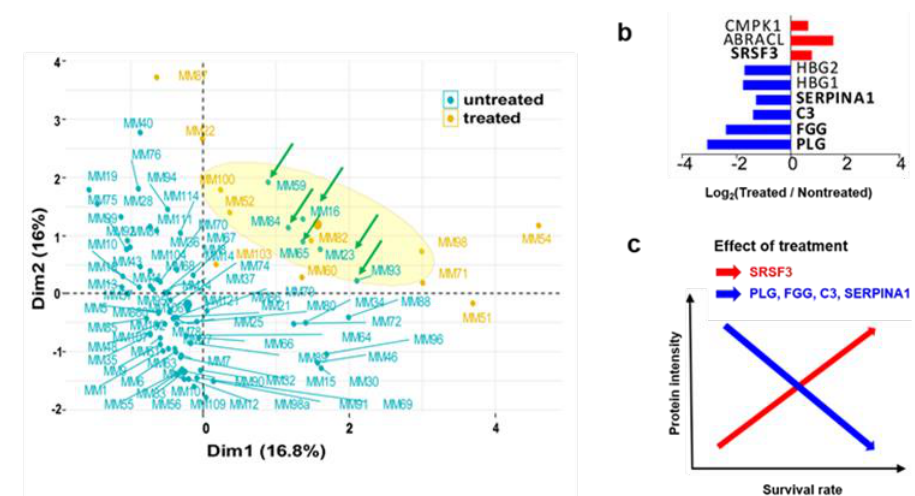
Figure 6. Drug treatment effects on protein expression in MM. ( a ) Multiple factor analysis based on clinical and histopathological information. Dots represent patients. The axes Dim1 and 2 represent the first two principal components that consider the contribution of all active groups of variables to define the distance between individuals (patients). The ellipse was generated at a 99% confidence interval. Green arrows indicate untreated patients selected to be compared with the treated patients (yellow) in further analyses. ( b ) Differentially expressed proteins between treated and untreated patients. Only proteins significantly associated (multiple linear regression, p -value < 0.05) with the variable treatment were considered relevant. ( c ) Association between protein intensity and survival rate in patients with melanoma [64]. The treatment leads to a long survival by increasing SRSF3 and decreasing PLG, FGG, C3, SERPINA1.